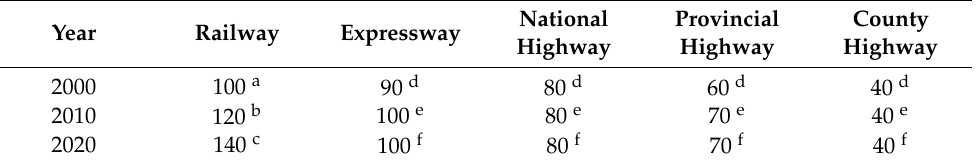
Table 2. Average driving speeds of different types of traffic routes (unit: km/h).